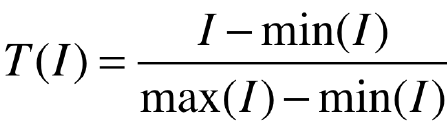
Figure 2. Equation to define the distance function.